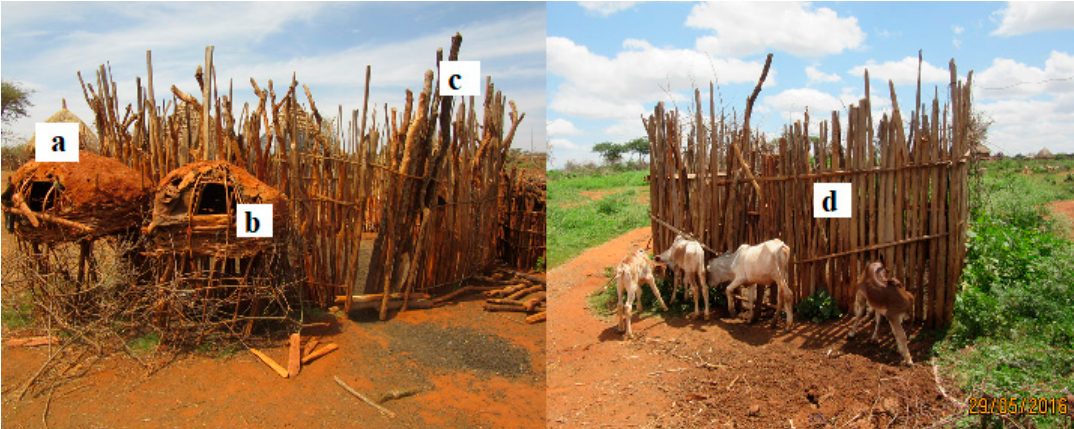
Figure 3. Kraal for goat kids ( a ) and lambs ( b ), matured sheep and goats ( c ) and calves ( d ) in Borana, southern Ethiopia. Photograph by the first author.